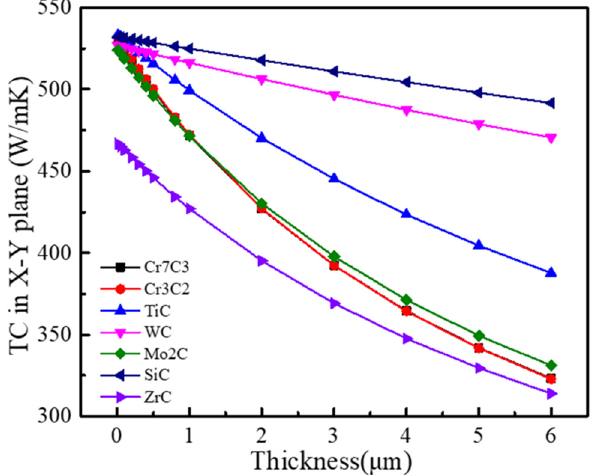
Figure 6: TC of graphite fl akes/Al composites with typical carbide coatings as a function of coating